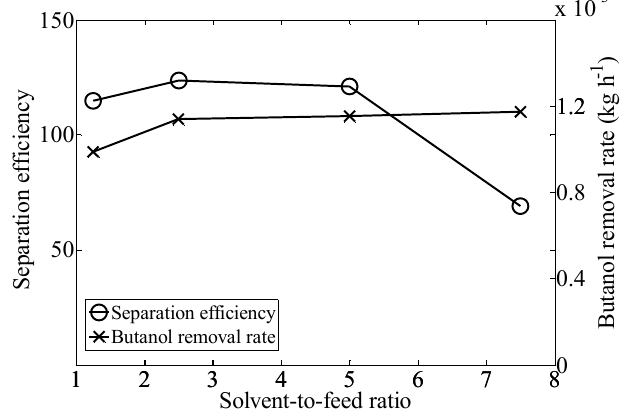
Figure 1. Effect of solvent-to-feed ratio on separation efficiency and butanol removal rate (kg·h − 1 ) at constant pressure (10.34 MPa) and temperature (25 °C).